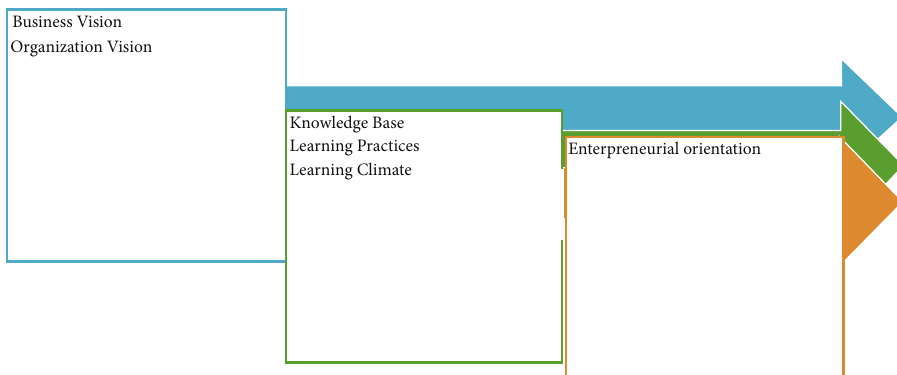
Figure 1: Organizational learning and business model